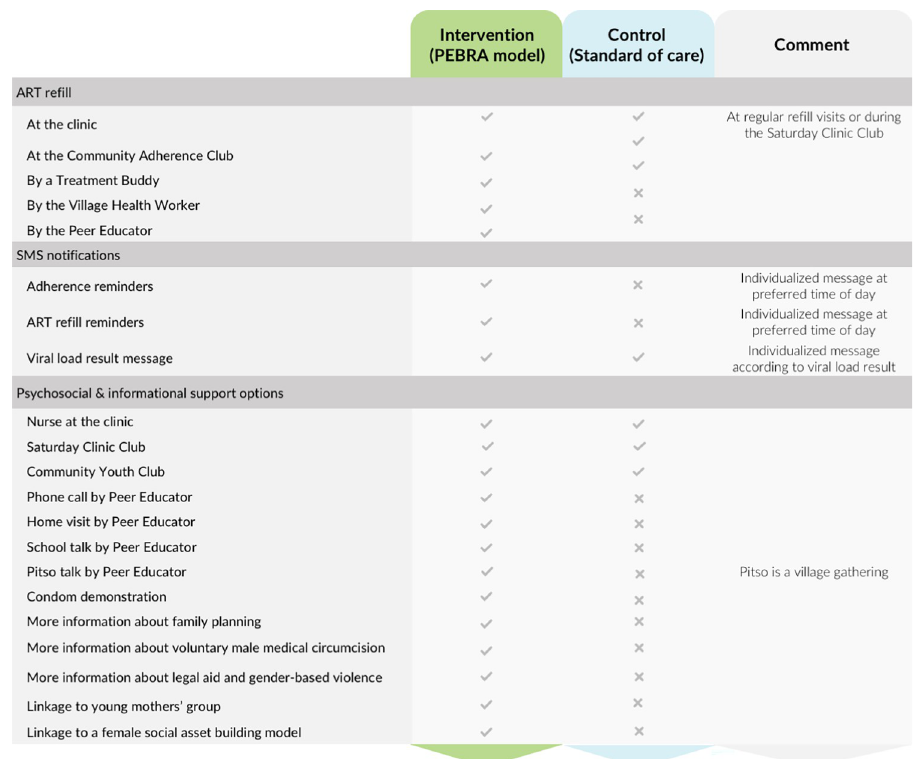
Fig 1. Description of the PEBRA model and clusters. ART, antiretroviral therapy; PEBRA, Peer Educator-Based Refill of ART.